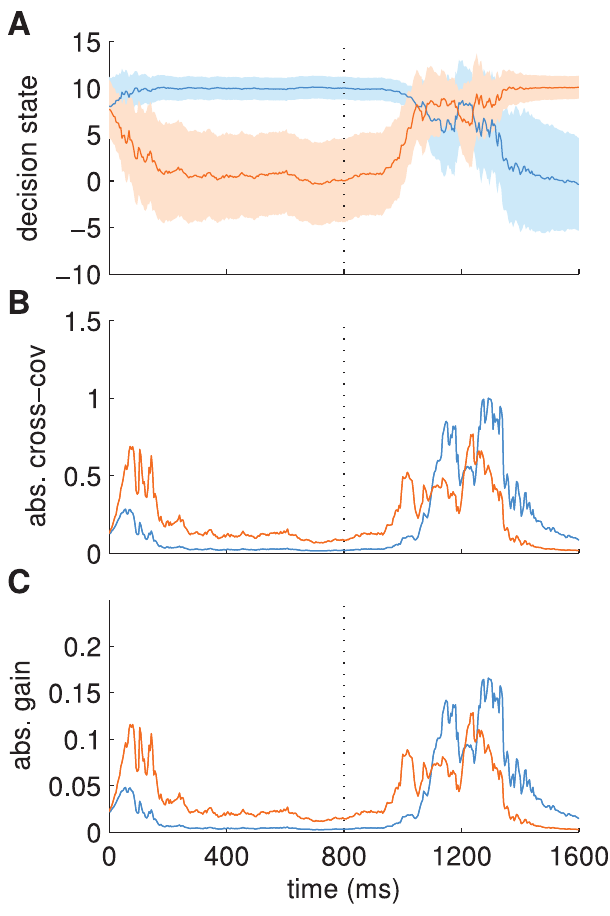
Fig 8. Example of a decision making trial with evolution of cross-covariance and gain for parameters of point B in Fig 7. Noisy exemplars of alternative 1 (blue) and subsequently of alternative 2 (orange) were shown with a switch at 800ms (cf. Fig 2). (A) Inferred decision state with mean state variables (lines) and two times their standard deviation (shading) indicating posterior uncertainty over decision state. State variable associated with alternative 1 shown in blue and associated with alternative 2 shown in orange. (B) Absolute cross-covariances between predicted observations and predicted decision state over time. Colours indicate cross-covariances associated with corresponding state variables as in A. Cross-covariances are large during their transition between fixed points. Once a fixed point is reached (i.e. a decision has been made) cross- covariances drop quickly. (C) Absolute gain values (elements of K t ) over time. Colouring as in B. Gain values are scaled cross-covariances, i.e., within-trial changes in gain are mostly driven by changes in cross-